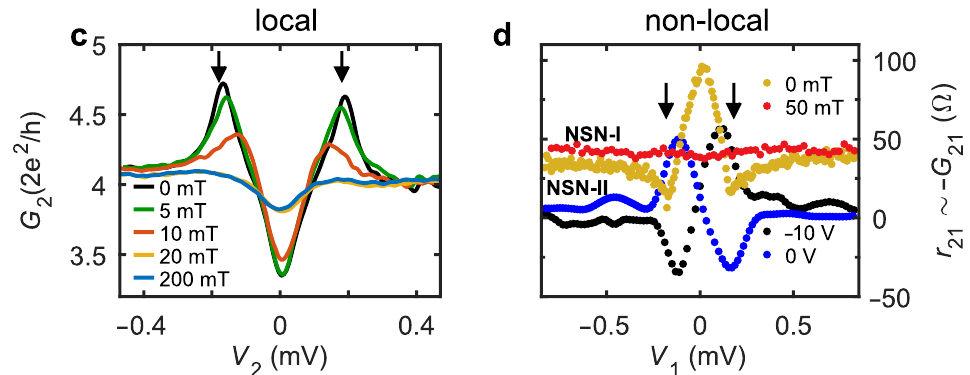
Figure 1. Outline and charge transport data. ( a ) Scanning electron microscope image of the typical device (false color). InAs NW is equipped with two N terminals (Ti/Au) on the sides and one S-terminal (Al) in the middle. ( b ) Separation of charge and heat currents at the InAs/Al interface and two noise measurement configurations. The three-terminal device layout allows studying thermal conductance G th of the proximitized NW region by measuring shot noise in the transmission configu- ration. Note that in the present experiment, only terminal N2 is connected to the low temperature amplifier, so that switching between the reflection noise S R and transmission noise S T is achieved by interchanging the biased and floating N-terminals, see the Supplemental Materials for the wiring scheme. ( c ) Local differential conductance of NS junction in device NSN-II measured at T = 50 mK in different magnetic fields. ( d ) Non-local differential resistance r 21 ≡ dV 2 / dI 1 for two devices plotted at different B and V g